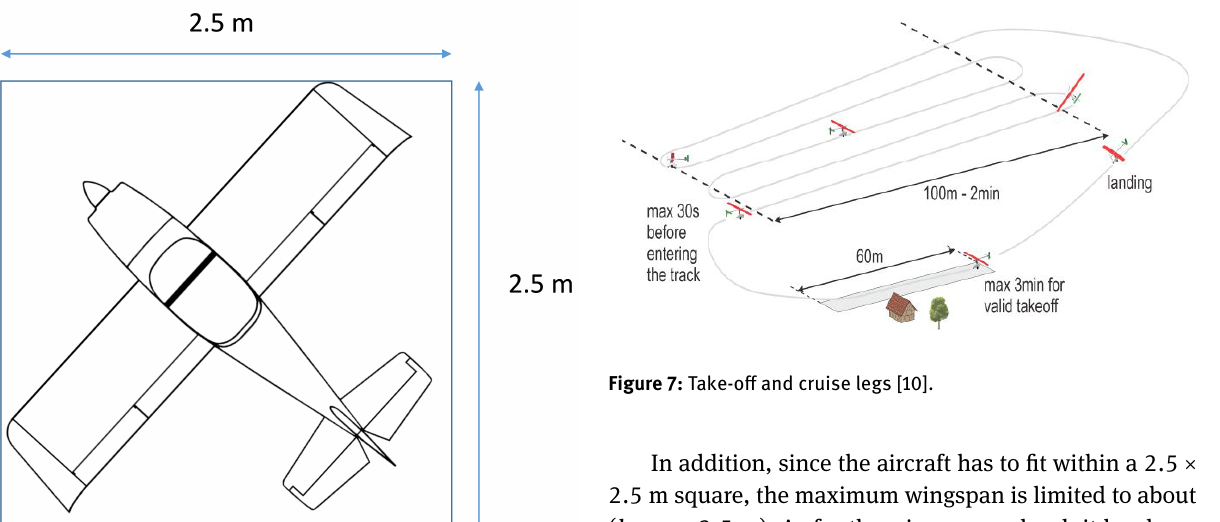
with Equation (1).